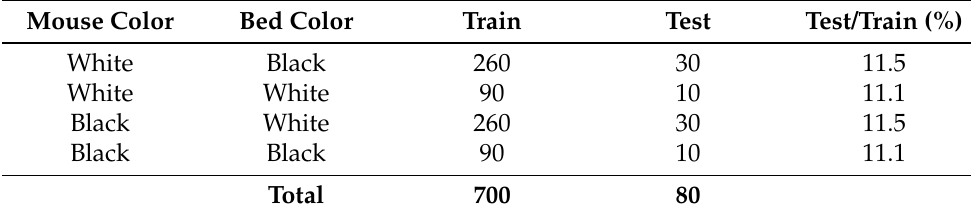
Table 1. Train and test dataset detailed